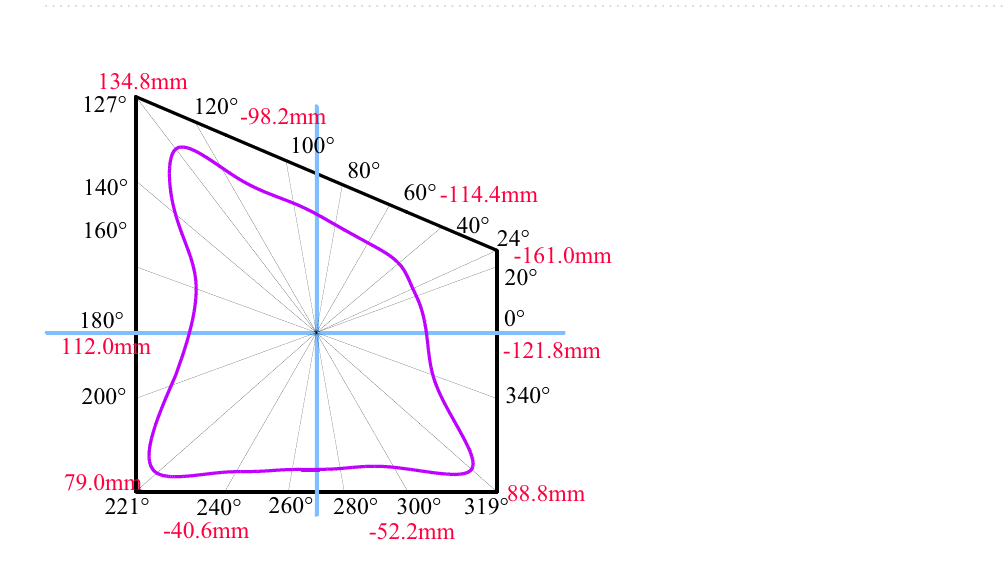
Figure 9. Deformation law of roadway surrounding